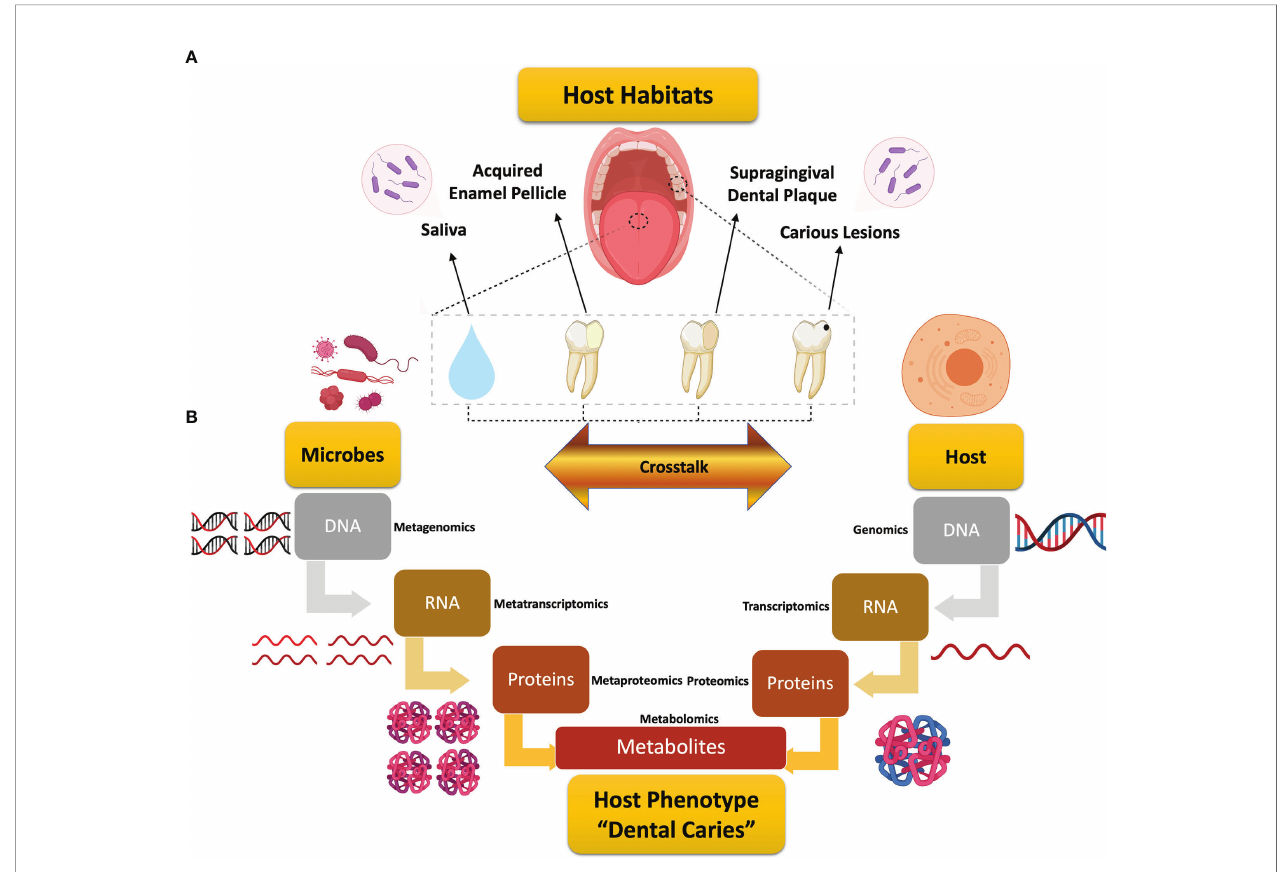
FIGURE 1 | Schematic diagram depicting the review design and work fl ow for global assessment of omics studies in dental caries research. (A) Illustration of the scope of this review for the studied host habitats in dental caries research. (B) Illustrative representation of the microbiome- and host-related fl ow of information along the central dogma of biology from the genomic data to the end products of metabolism that could individually or jointly underlie the expression of dental caries. Each stage is associated with the corresponding systems biology tool, from genomics to metabolomics, with added “ meta ” pre fi x that implies “ many ” for the multispecies microbial communities. Metabolomics, the analytical tool for metabolites, embraces the microbial metabolism and microbial – host